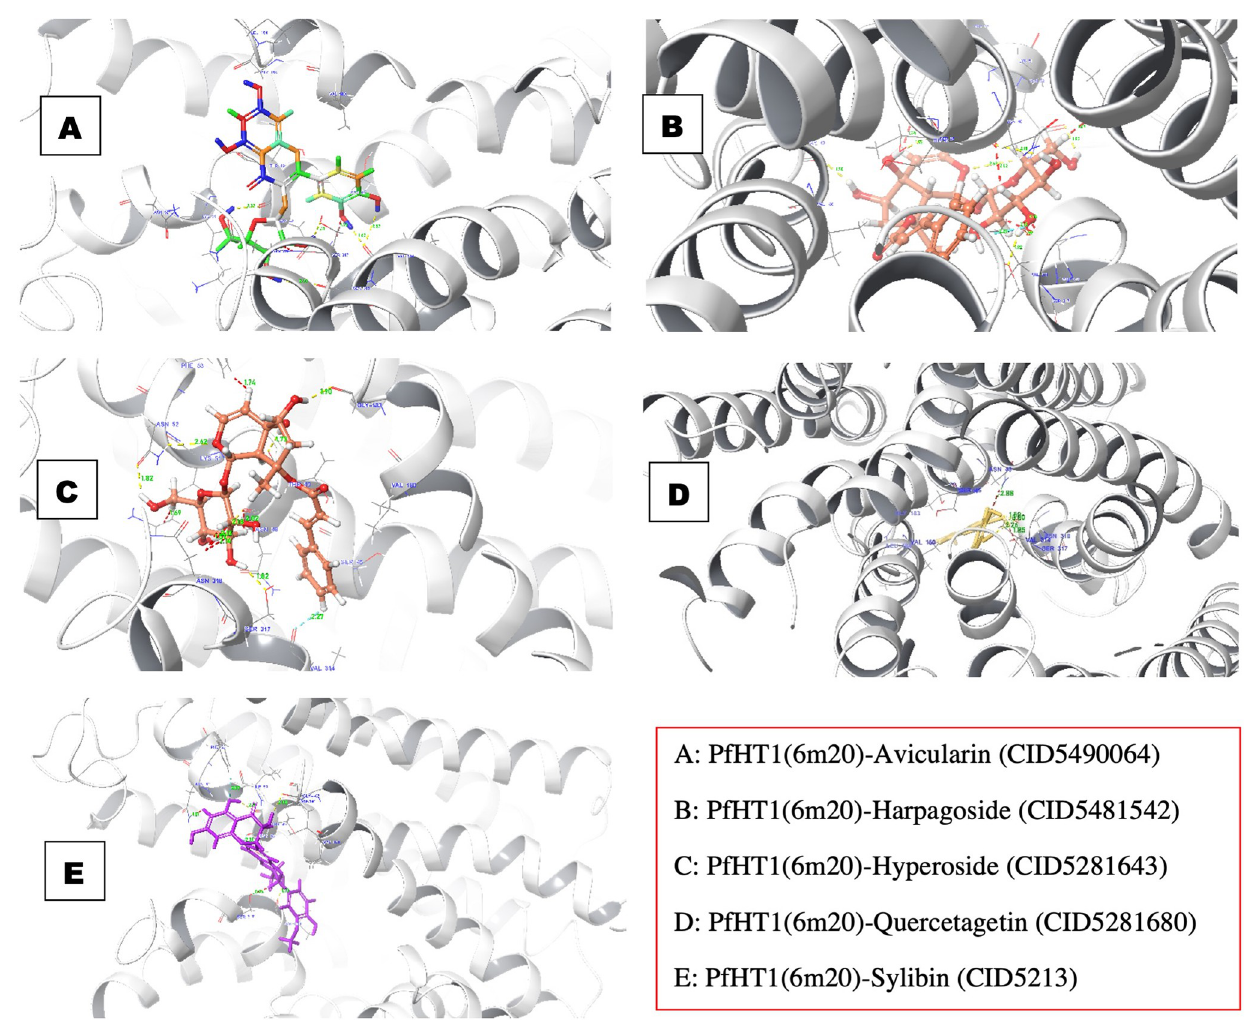
Fig 4. The 3D structures of interaction profile of PfHT1(6M20)–ligand complexes after molecular docking